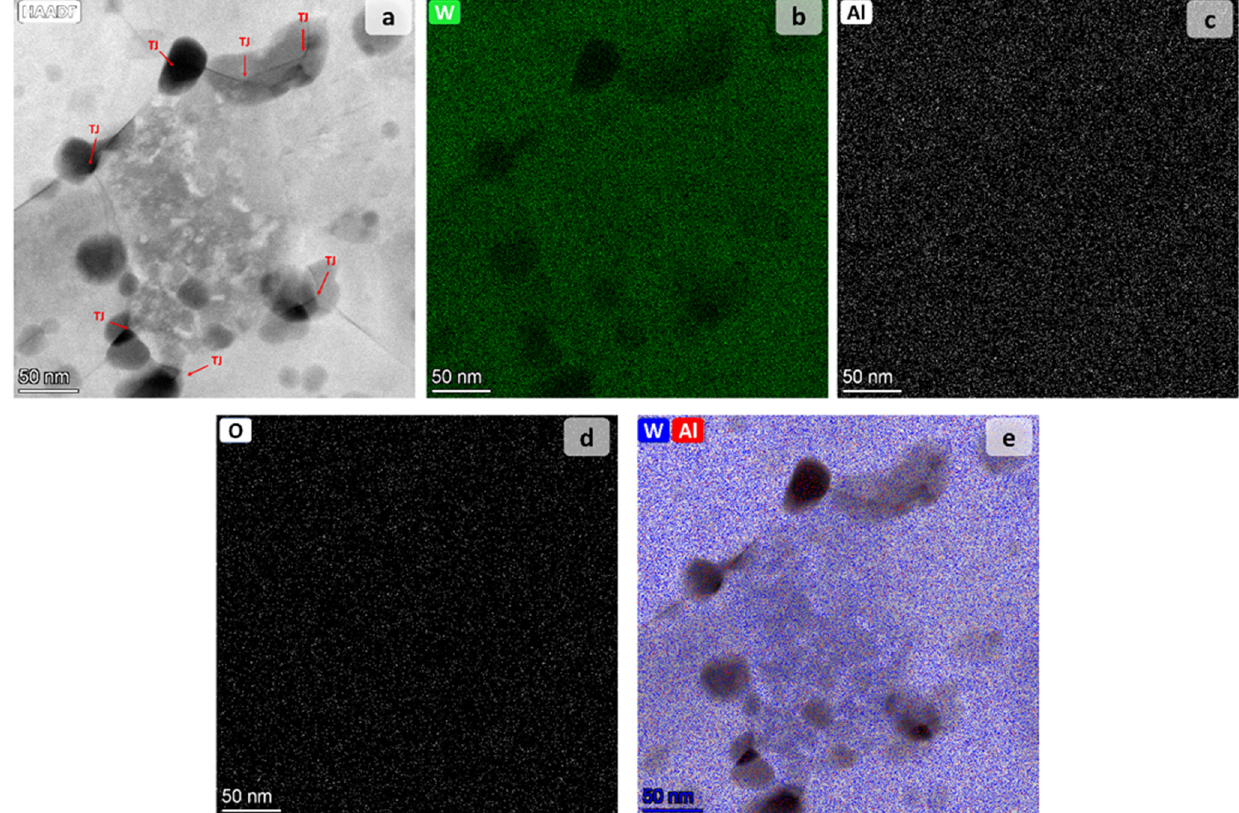
Figure 8. TEM micrograph and chemical mapping of W 80 Al 20 powders after annealing at 900 °C: ( a ) HAADF image of the microstructure showing darker region which preferentially locate at GBs and triple junctions; chemical distributions of ( b ) W, ( c ) Al and ( d ) O; ( e ) Superimposition of W and Al distribution with HAADR micrograph. Triple junctions (TJ) are indicated by red arrows in Figure ( a ).